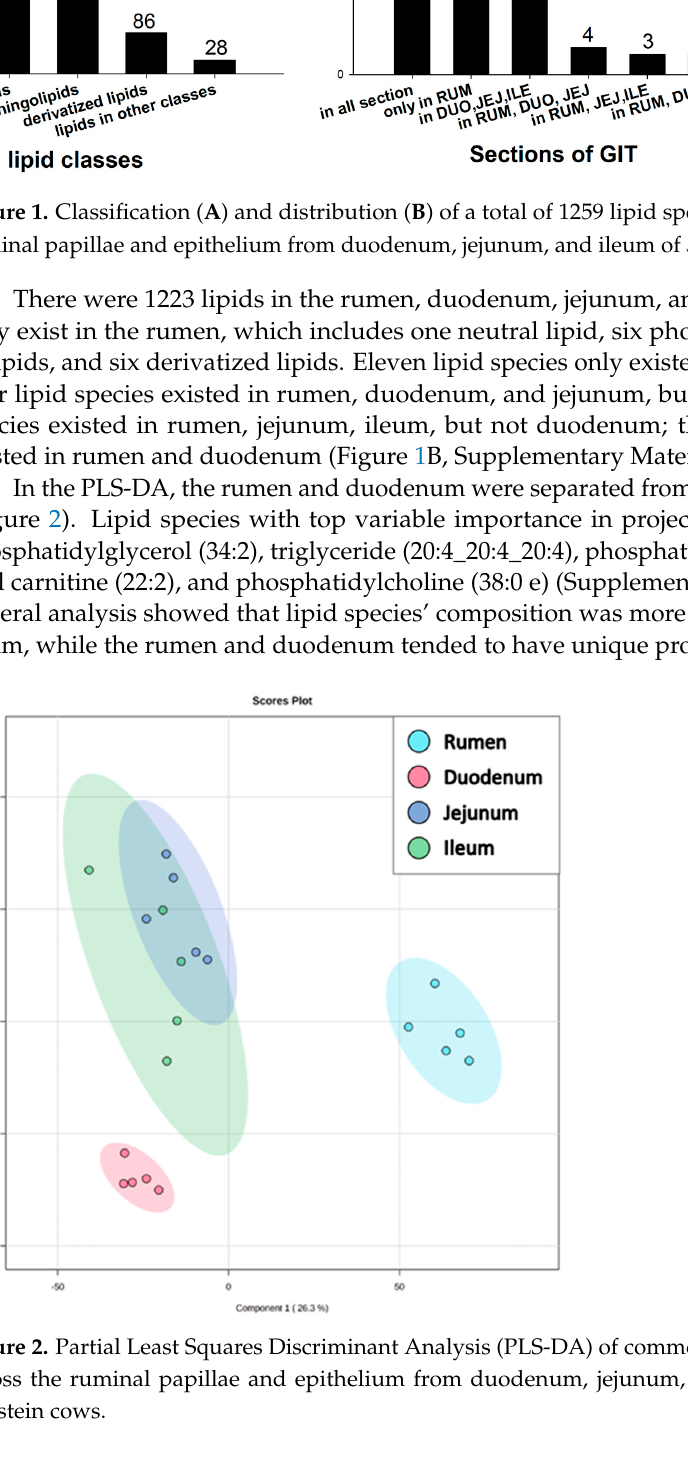
Figure 2. Partial Least Squares Discriminant Analysis (PLS-DA) of common lipid species identified across the ruminal papillae and epithelium from duodenum, jejunum, and ileum of 5 lactating Holstein cows.